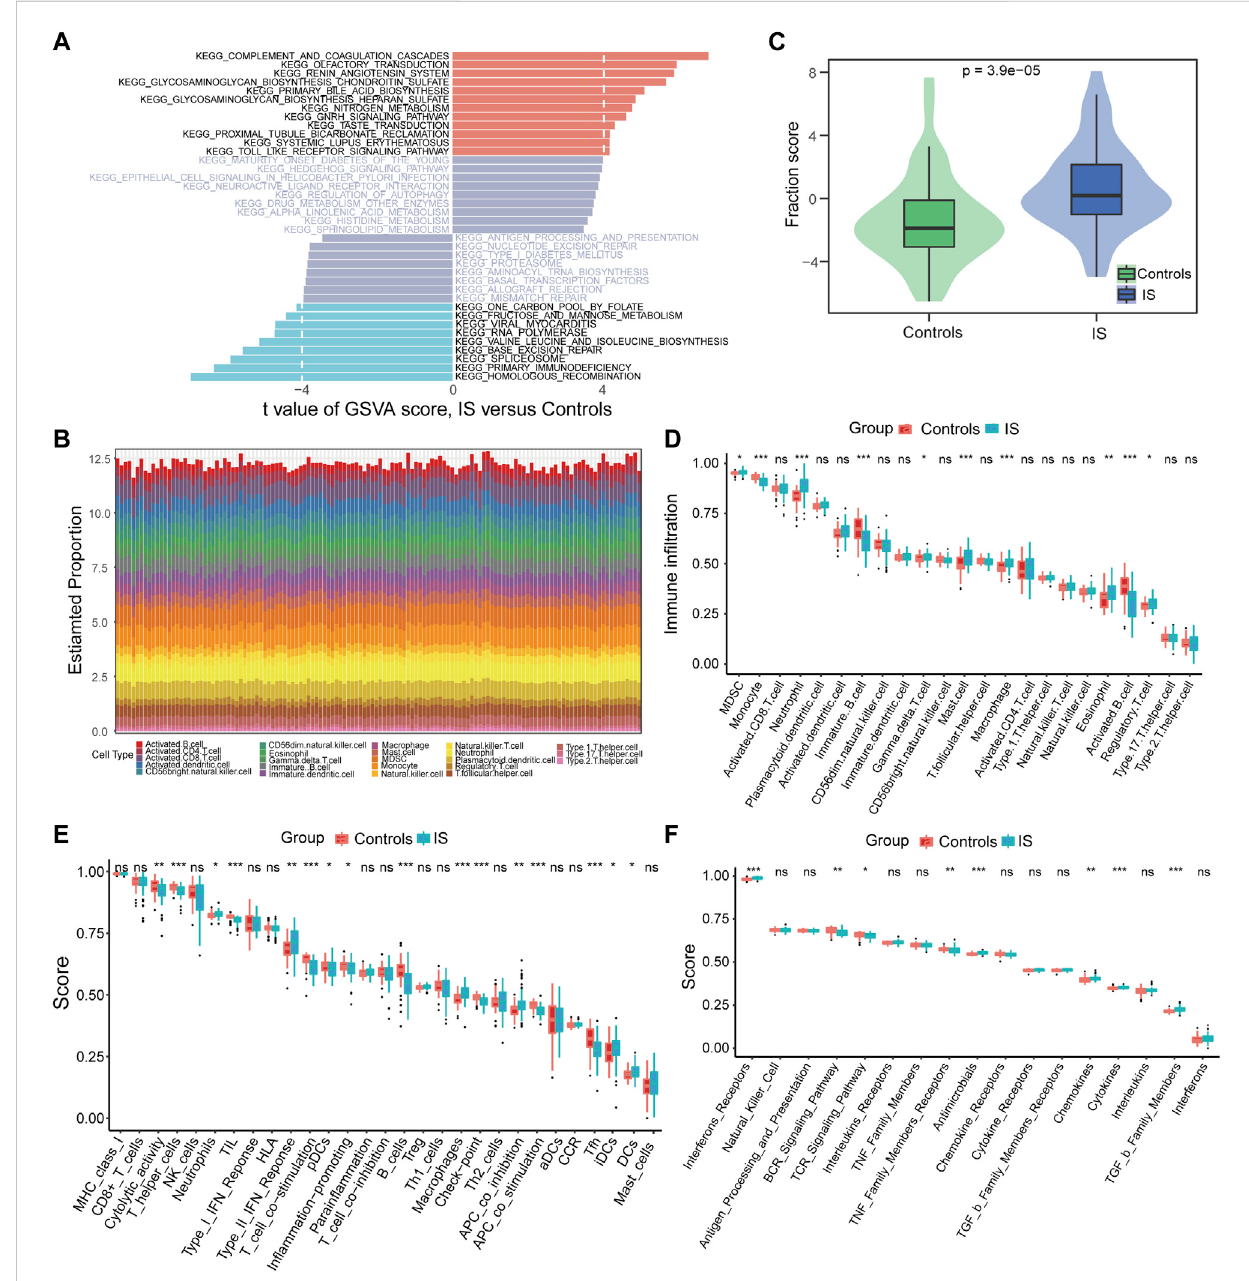
FIGURE 3 Differencesintheimmunemicroenvironmentwereidenti fi edbetweencontrolsandISsamples. (A) DifferencesofKEGGpathwayenrichmentscore. (B) Relative proportions of immune cell in fi ltration for each sample. (C) Differences of immune cell in fi ltration scores ( p = 3.9*e − 5 ). (D – F) Box plot of the abundance differences of immune microenvironment characteristics including in fi ltrating immune cells, immune functions, and immune responses, respectively. * p < 0.05, ** p < 0.01, and *** p < 0.001, “ ns ” indicates no signi fi